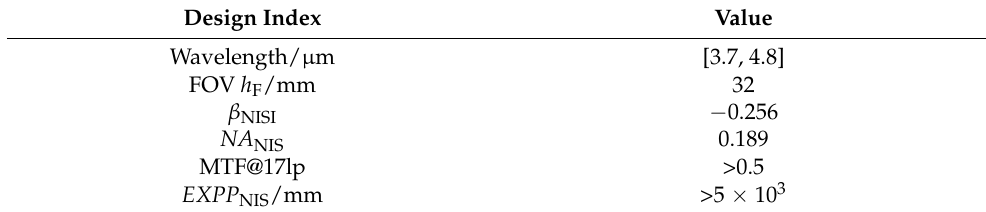
Table 4. NIS design index.